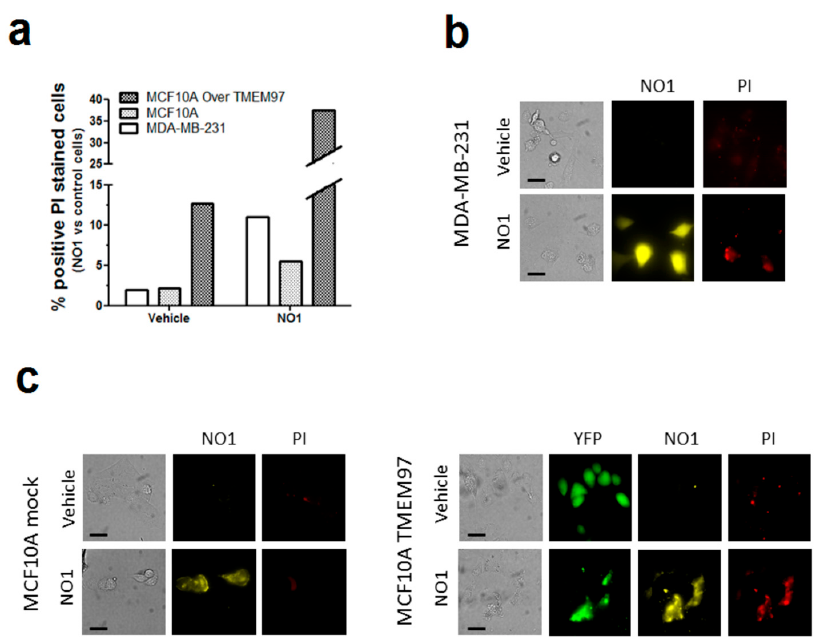
Figure 3. NO1 cell death as evidenced by the PI staining in MDA-MB-231 cells. ( a – c ) MDA-MB-231 cells, MCF10A, and MCF10A overexpressing TMEM97 cells were shed at the appropriate concentration, and were incubated for 45 min with propidium iodide (PI, 4 μ M). During the final 30 min, the extracellular medium was supplemented with either the vehicle or NO1 (100 nM). When the incubation time was over, pictures of the different cells under the different experimental conditions were acquired, as described in the Material and Methods section. ( a ) Bar graph represents the percentage of positive PI stained cells after administration of NO1 vs. nontreated cells (vehicle), which results of the analysis of around 200 cells from four different independent transfections. Bars in the images represent 50 μ m.